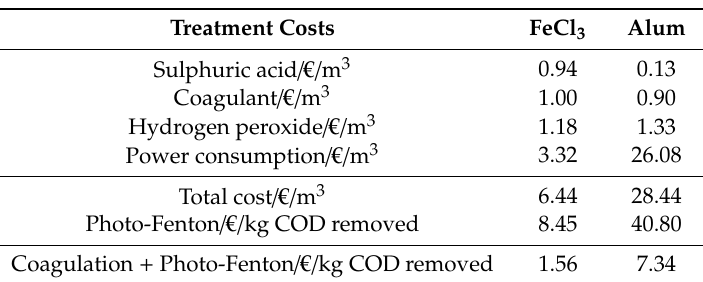
Table 5. Estimation of treatment costs by coagulation at optimal conditions and Fenton process using H 2 O 2 / COD =